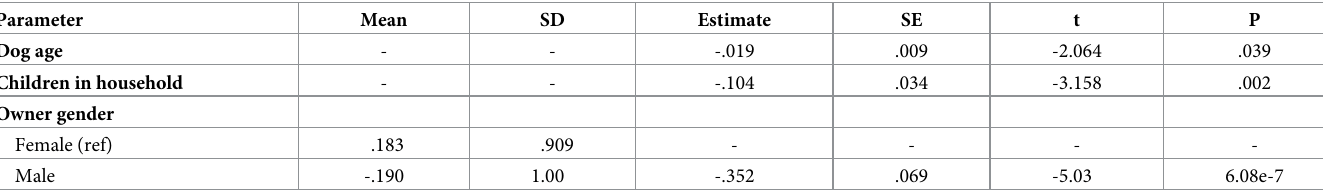
Table 14. Statistically significant interactions of owner and dog parameters on LAPS factor